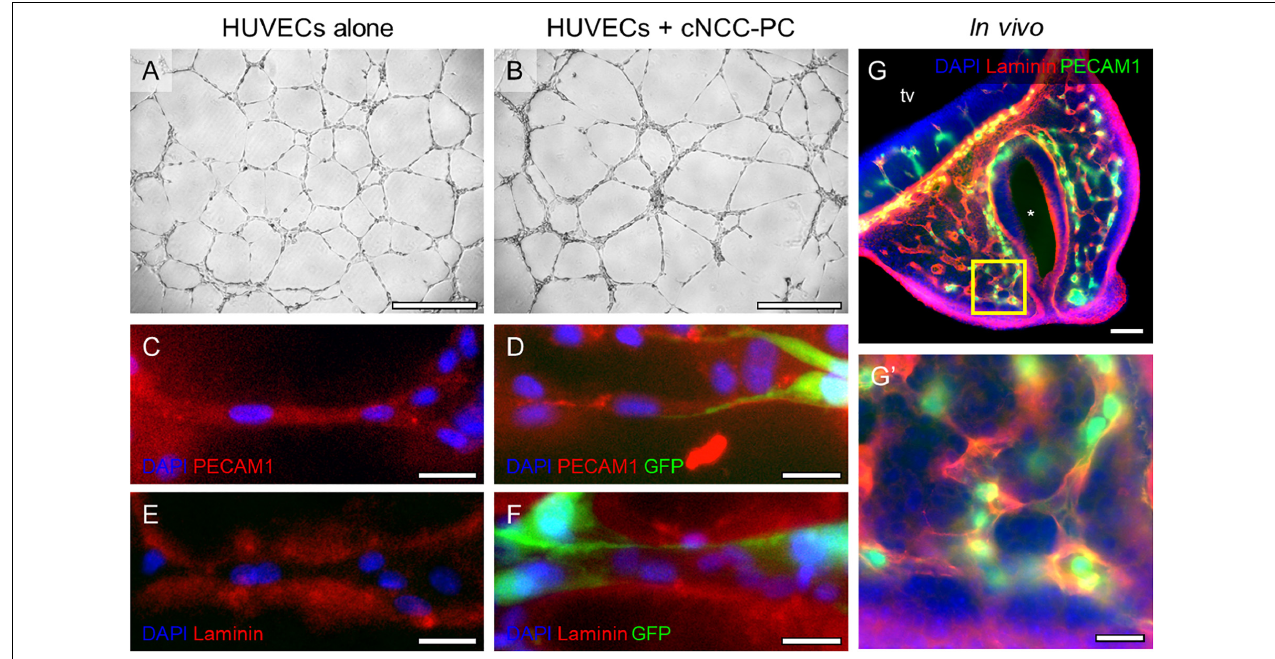
FIGURE 4 | cNCC-derived pericytes interact with endothelial cell cords. (A,B) Phase contrast images of HUVECs alone or HUVECs with GFP-expressing pericyte-differentiated cNCCs (cNCC-PC) plated at a ratio of 8:1 on Matrigel for 8 h. Scale bar is 500 µ m. (C–F) Cords were stained for PECAM1 to mark endothelial cells or for the extracellular matrix protein Laminin. GFP marks cNCC-PC, and DAPI was used to stain nuclei. Scale bars are 25 µ m. (G) A 50- µ m coronal section from a control GD11 embryo head was stained for PECAM1 and Laminin to visualize the microvasculature. tv, telencephalic vesicle, * indicates the nasal pit. Scale bar is 100 µ m. (G’) A higher magnification image of the field indicated by the box in the medial nasal process in (G) . Scale bar is 25 µ m.